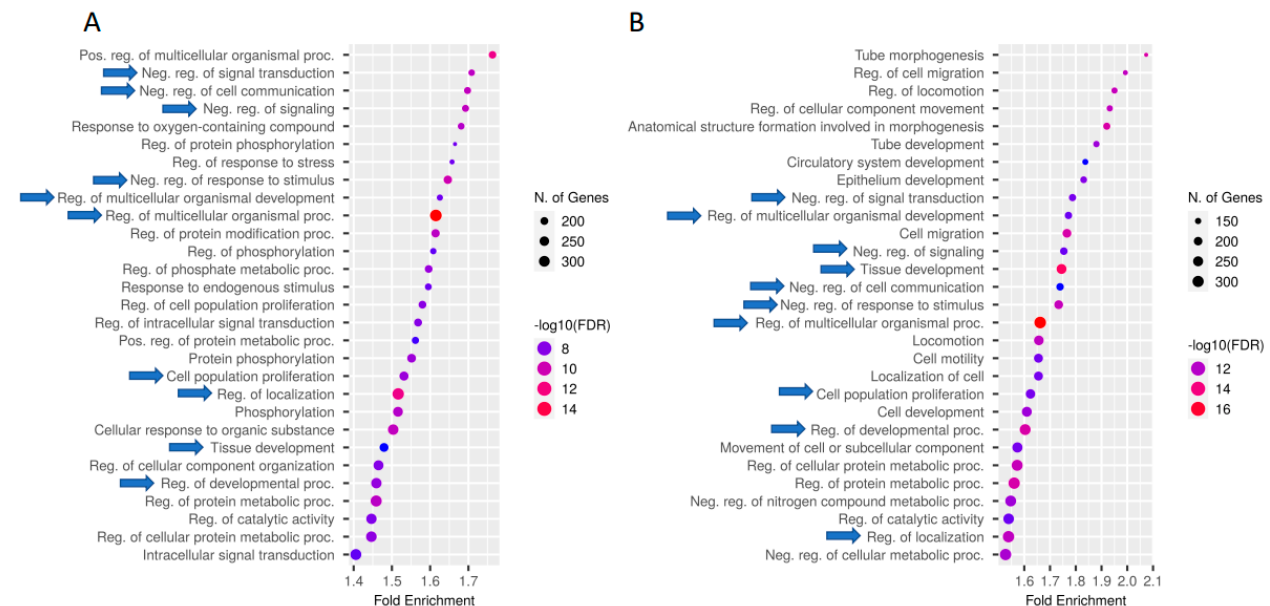
Figure 2. GO enrichment results for the induced ( A ) and repressed ( B ) differentially CTCF-binding sites after weaning. The top 30 hits of GO terms are shown in this figure. Biological processes are ranked according to the fold enrichment values. Bubble colors represent the p -value of the False Discovery Rate (FDR). The most significant processes are highlighted in red, and the less significant processes are highlighted in blue according to log 10 (FDR) values. Bubble sizes indicate the number of genes. Blue arrows indicate GO terms present in both induced and repressed sites.